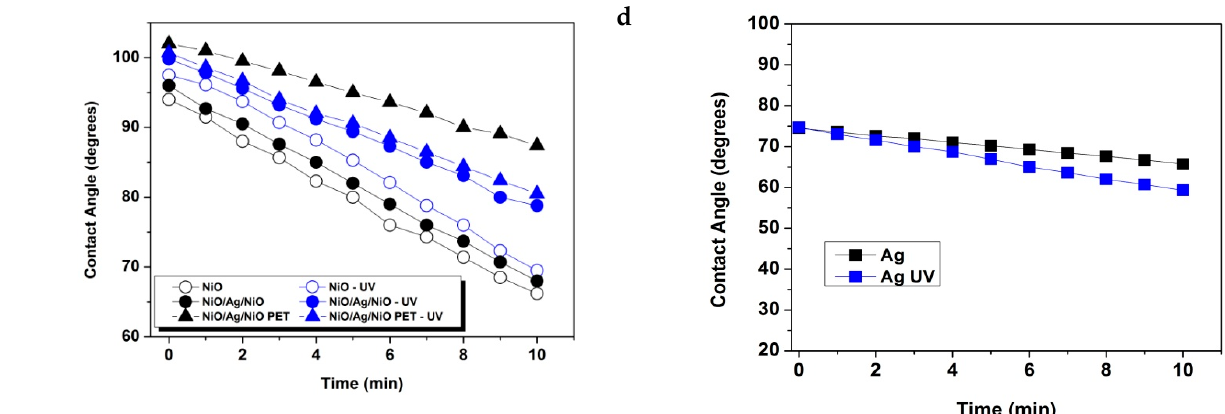
Figure 4. Contact angle measurements with and without UV irradiation for single and three-layer samples: ( a ) TiO 2 ; ( b ) TiO 2 :Nb; ( c ) Nio; ( d ) Ag interlayer.